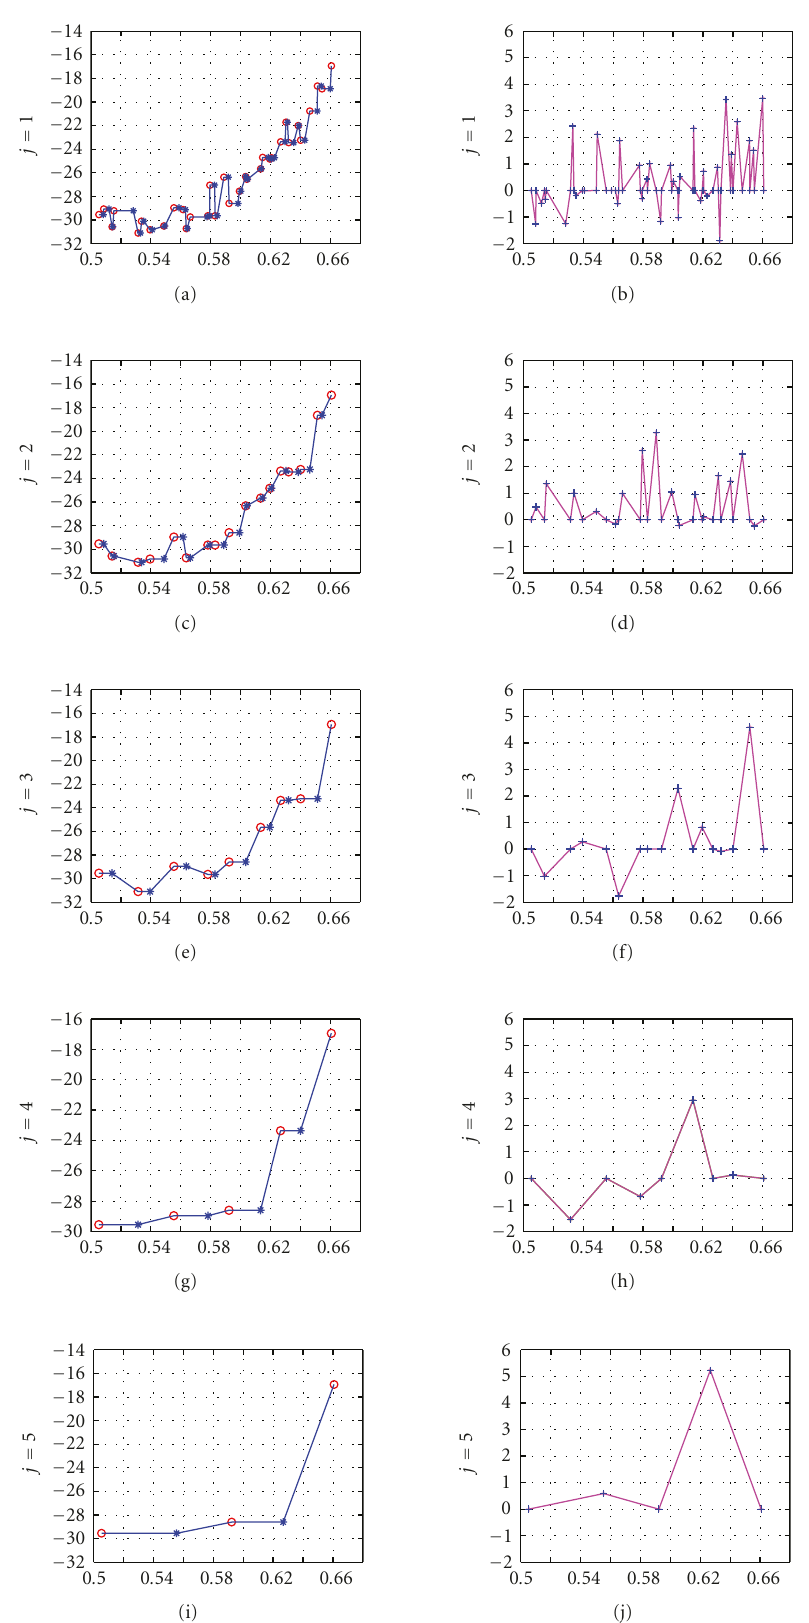
Figure 12: Multiresolution analysis on five resolution levels using Haar scaling and wavelet